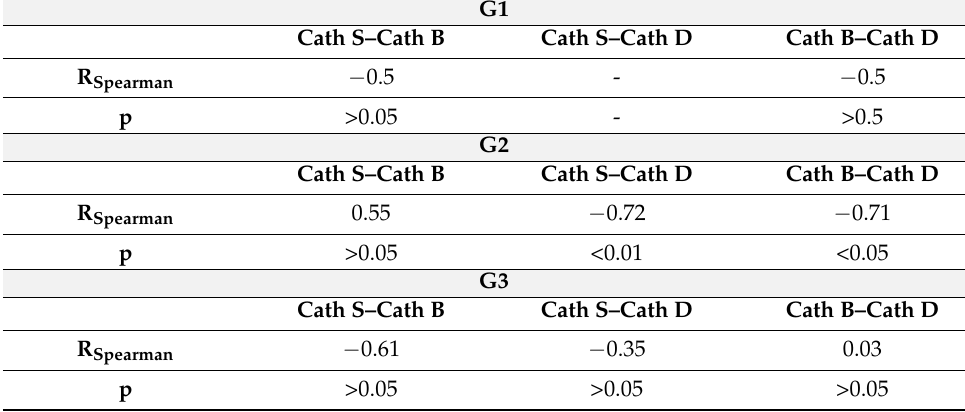
Table A3. Correlation analysis between